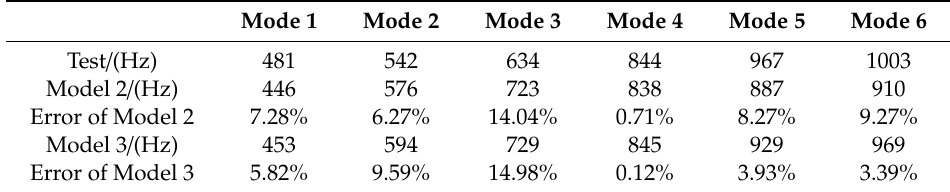
Table 5. Comparison of natural frequencies between the experimental and simulation results.